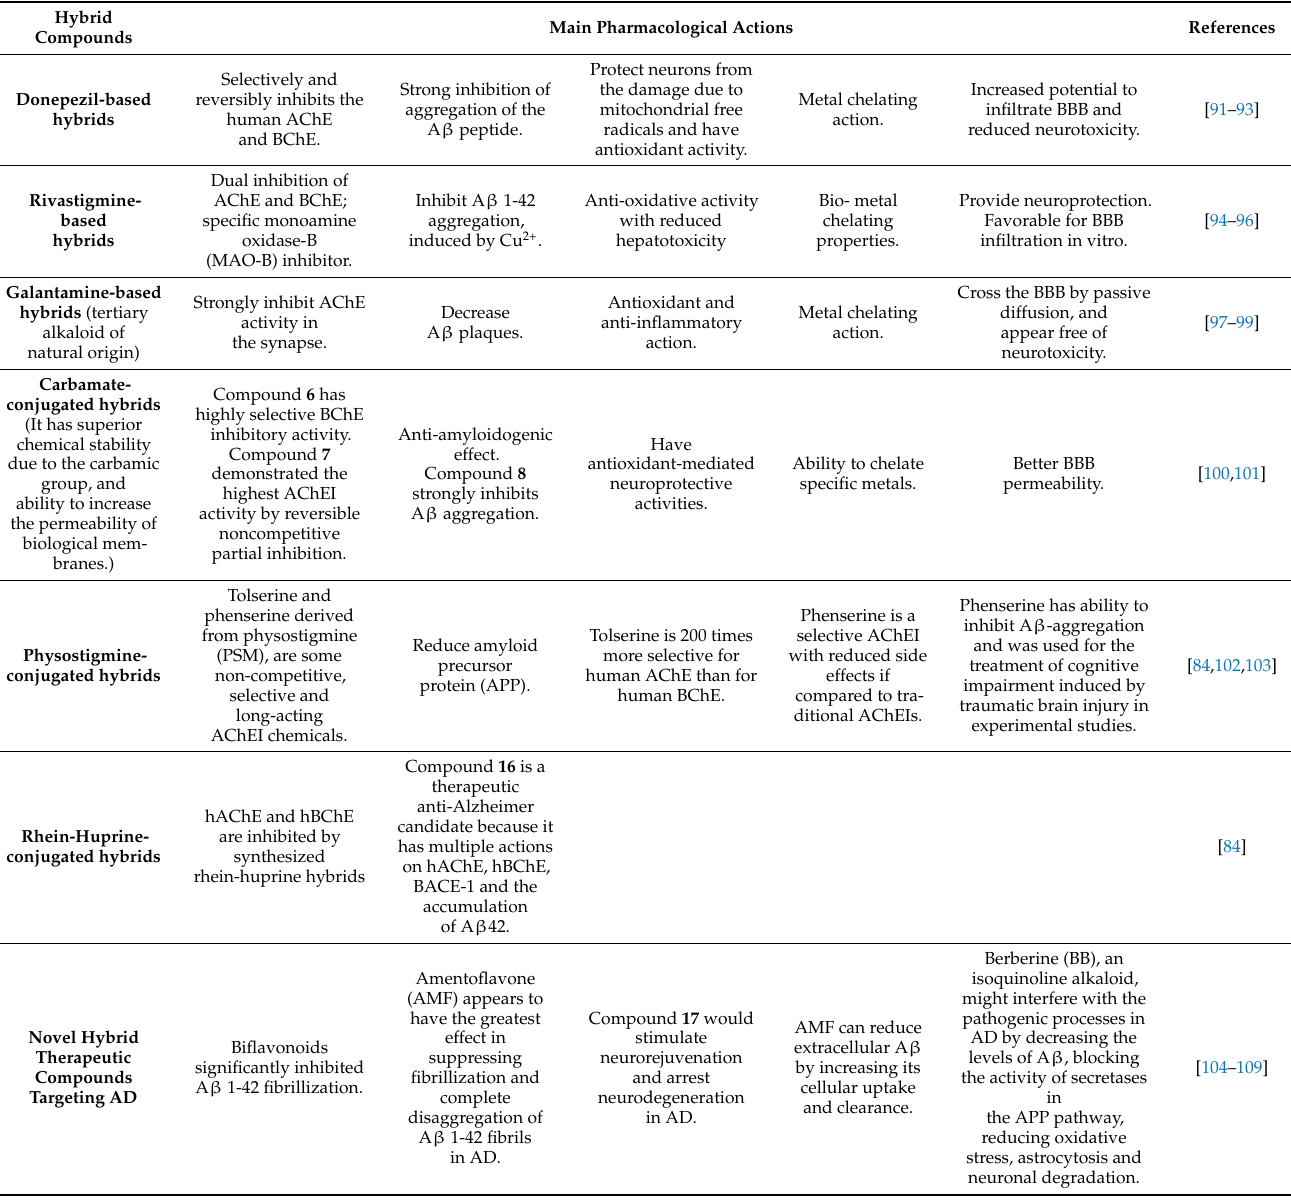
Table 1. Anticholinergic structure-based hybrids as potential multitarget compounds for AD